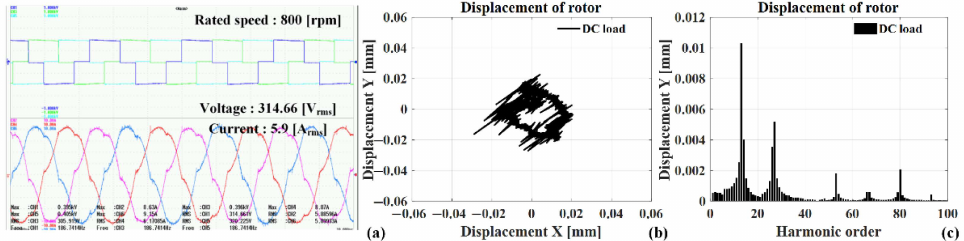
Figure 17. Experimental results for the DC load condition: ( a ) measurement of voltage and current; ( b ) rotor displacement; ( c ) FFT analysis results for the rotor